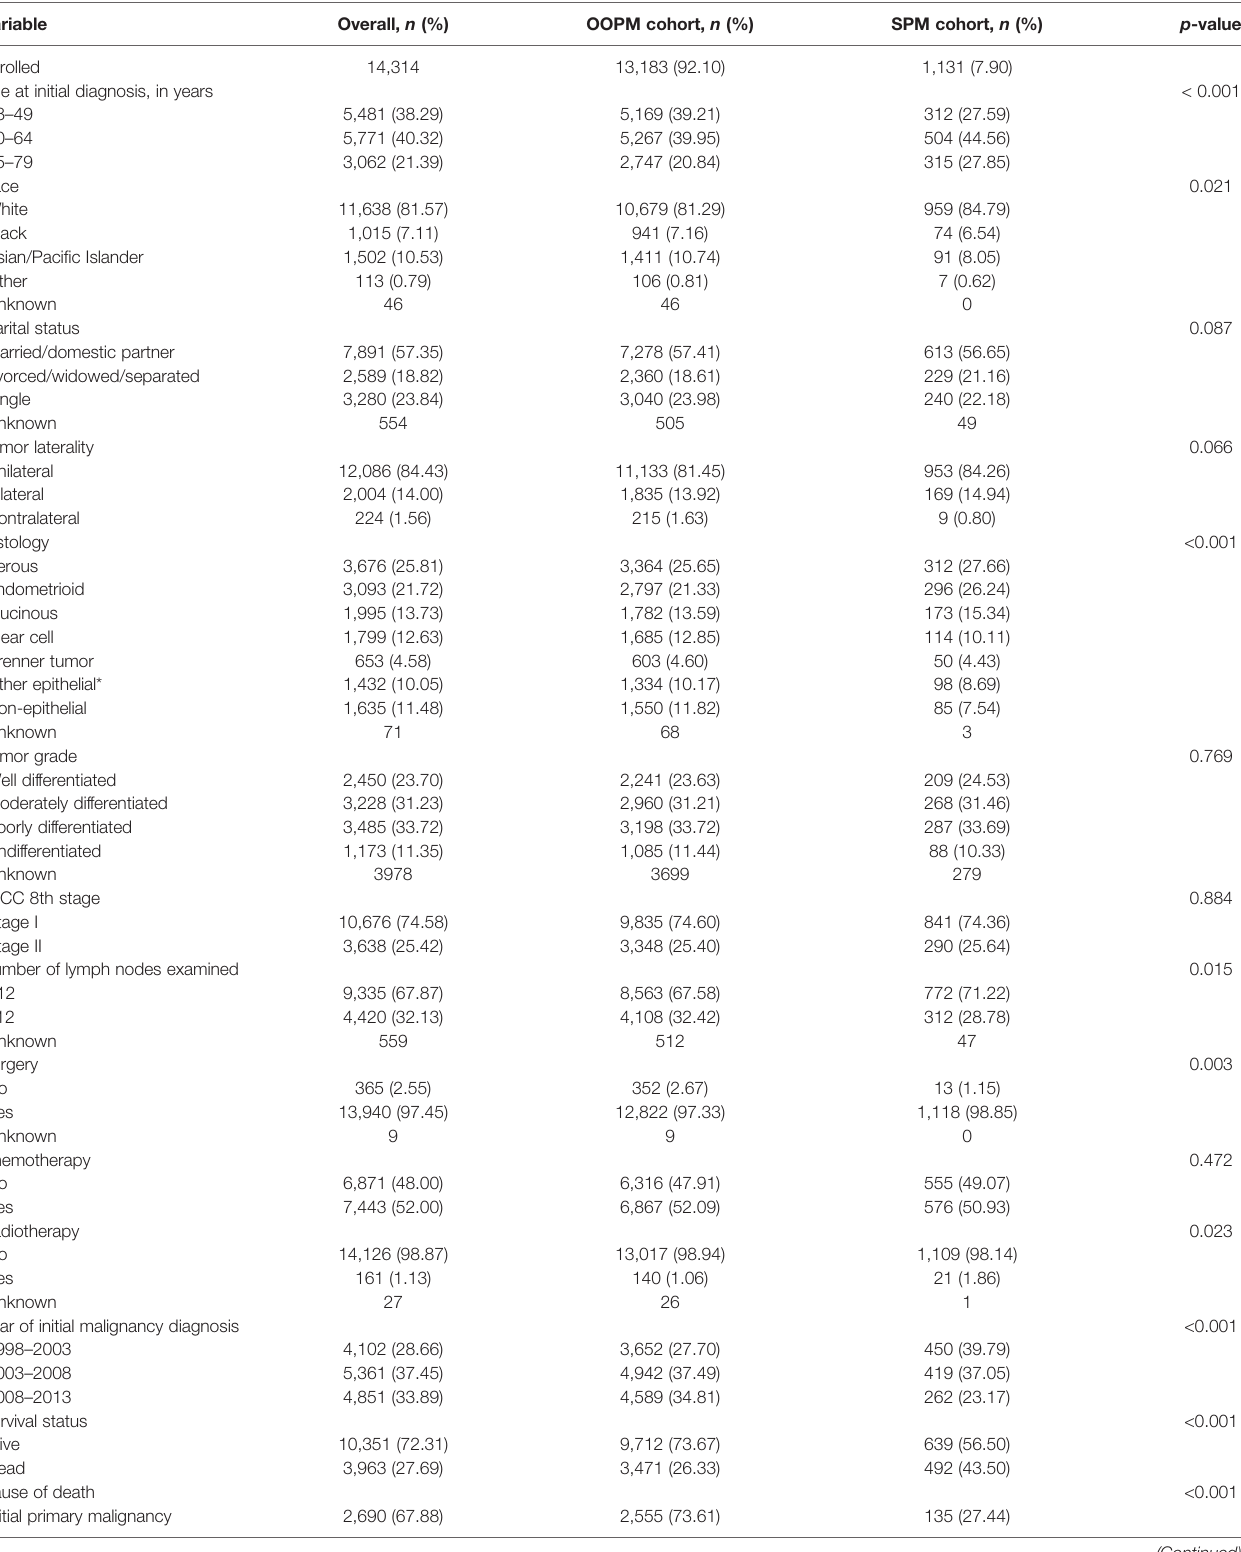
TABLE 1 | Demographic and clinicopathological characteristics of early-stage ovarian cancer patients with only one primary malignancy or with second primary malignancies. Variable p -value